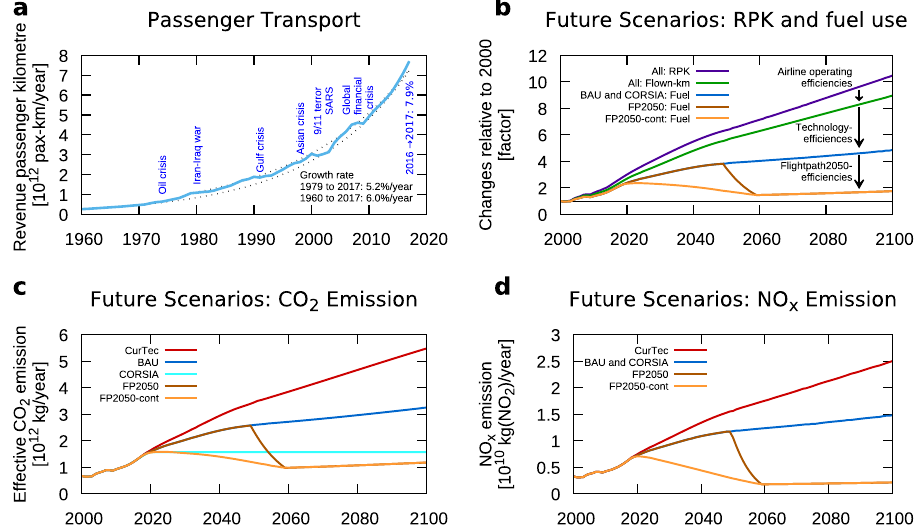
Fig. 1 Global aviation transportation and related emissions for fi ve scenarios. They include the future use of current technology, i.e. without technology improvements (CurTec), with a business-as-usual future technological improvement (BAU), the offsetting scheme of the international civil aviation organisation (CORSIA), and 2 Flightpath 2050 scenarios which differ in the speed of technology improvements (FP2050 and FP2050-cont). a Revenue passenger kilometres as provided by ICAO; dotted lines provide exponential growth rates. b Future changes relative to their respective values in the year 2000 for revenue passenger kilometres (violet), fl own distances (green), the fuel consumption of the scenarios BAU and CORSIA (blue), and the FP2050 scenarios (brown). c Future CO 2 emissions for the scenarios CurTec (red), BAU (blue), CORSIA (light blue), FP2050 with late technology advancements (dark brown) and continuous technology advancements (brown). Note that for CORSIA the effective CO 2 emission is considered, including reductions due to the use of sustainable alternative fuels (SAF) and capping net emissions. d as bottom-left, but for NO x emissions; note that the NO x emissions for BAU and CORSIA are identical. The order in the legend is the same as the lines appear in the